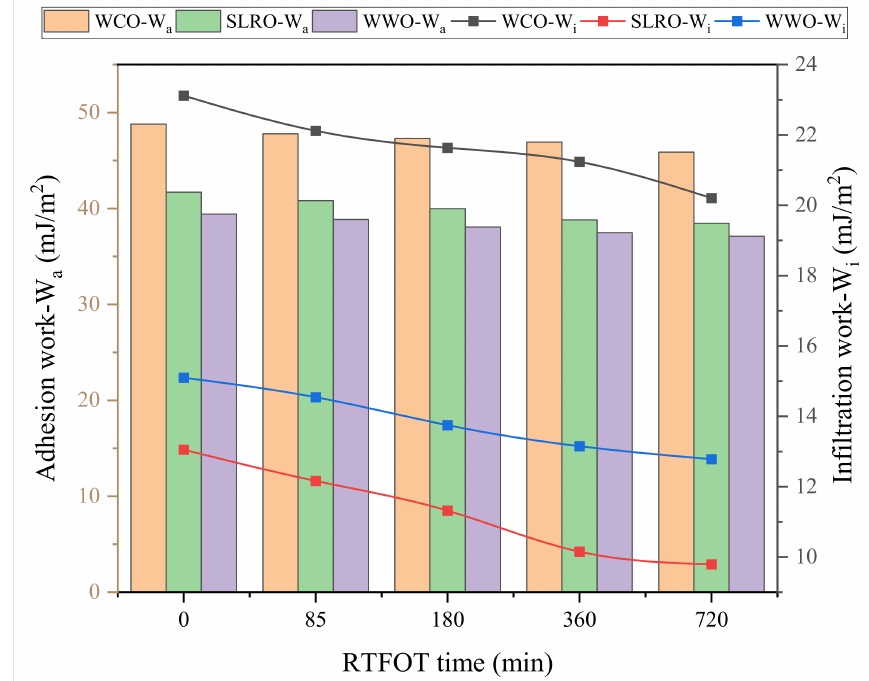
Figure 4. W a and W i of the bio-oils on different aged bitumen surfaces at 408.15 K.